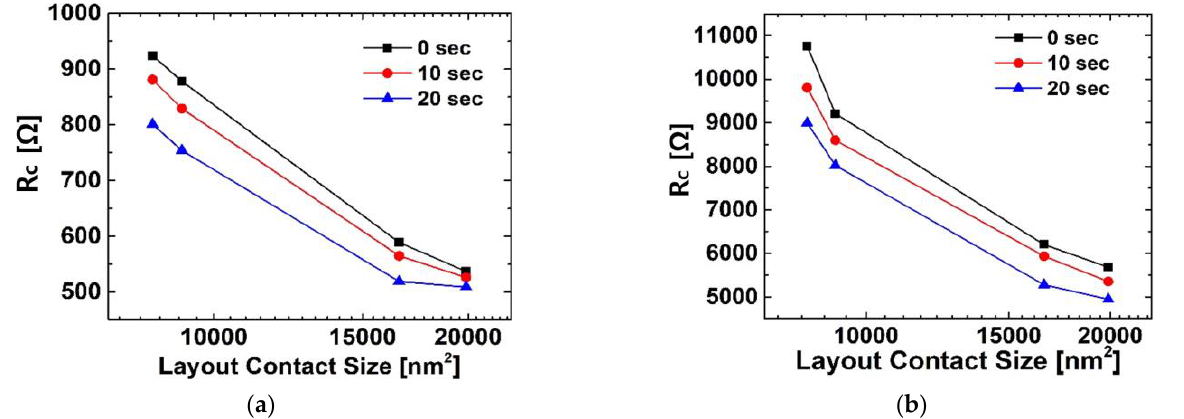
Figure 3. The contact resistances as a function of the sizes and the processing time. ( a ) N+ contacts and ( b ) P+ contacts. and ( b ) P+